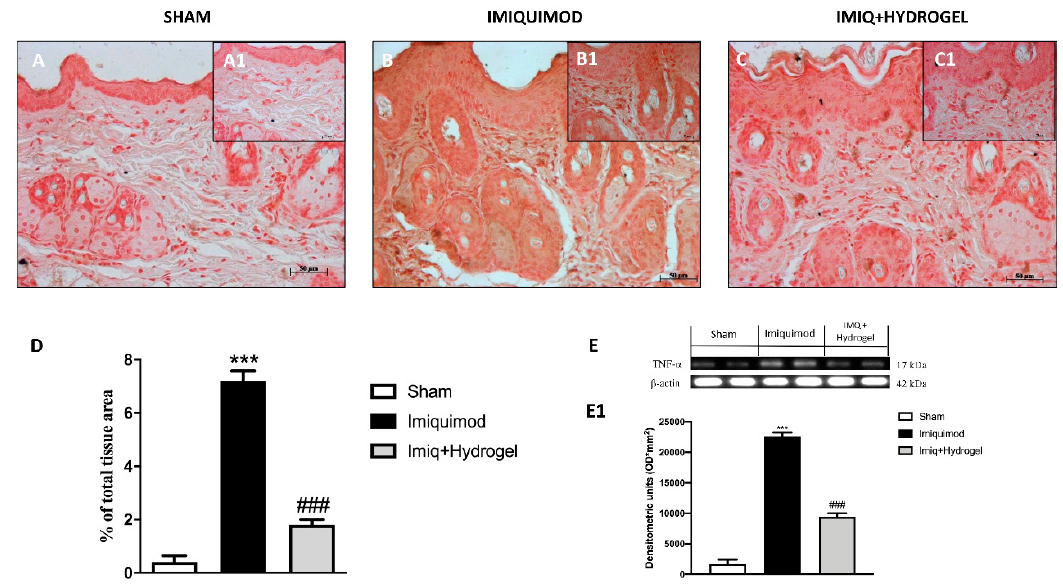
Figure 6. Effect of Hydrogel treatment on TNF- α expression . Immunohistochemical analysis of TNF- α revealed a significantly increased expression in the vehicle group ( B magnification 20×, B1 magnification 40× D , E,E1 ) compared to the control group ( A , B magnification 20×, A1 magnification 40×, D , E , E1 ). Hydrogel treatment reduced the expression of TNF- α in animals exposed to IMQ damage ( C , B magnification 20×, C1 magnification 40×, D , E , E1 ). Data are representative of at least three independent experiments; One-Way ANOVA test. *** p < 0.001 vs. sham; ### p < 0.001 vs. IMQ.